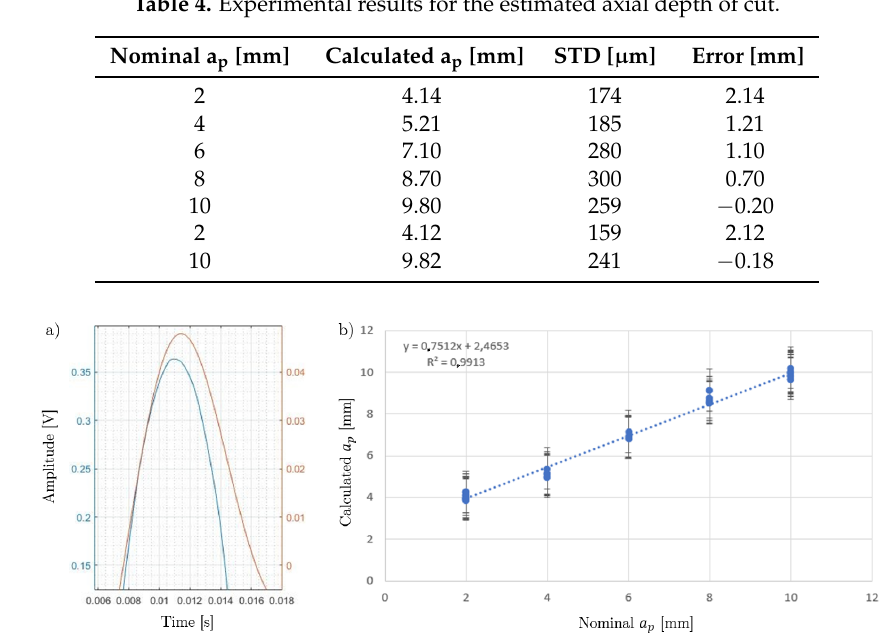
Figure 9. Experimental results. ( a ) Exit time delay between the cutting force signal (blue) and filtered AE signal (orange). ( b ) Calibration curve: estimated vs. nominal depth of